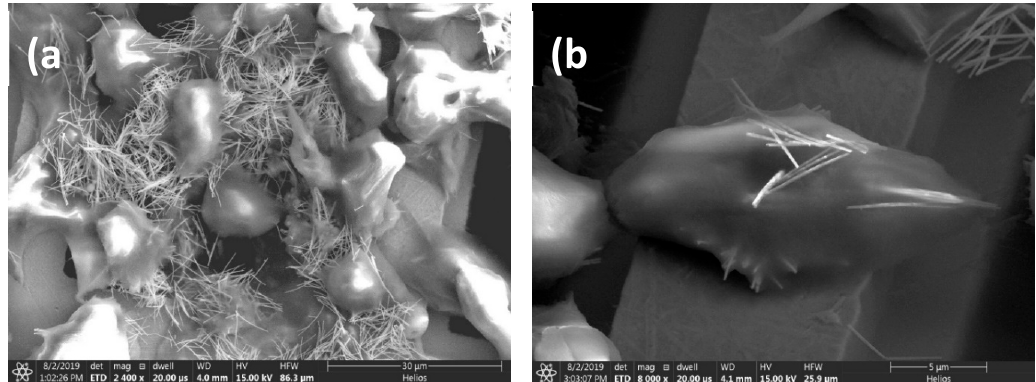
Figure 3. SEM images of Ni MNWs inside OSCA-8 cells with different magnifications: ( a ) image of several cells showcasing the presence of non-internalized MNWs, and ( b ) image of a single cell with internalized MNWs.